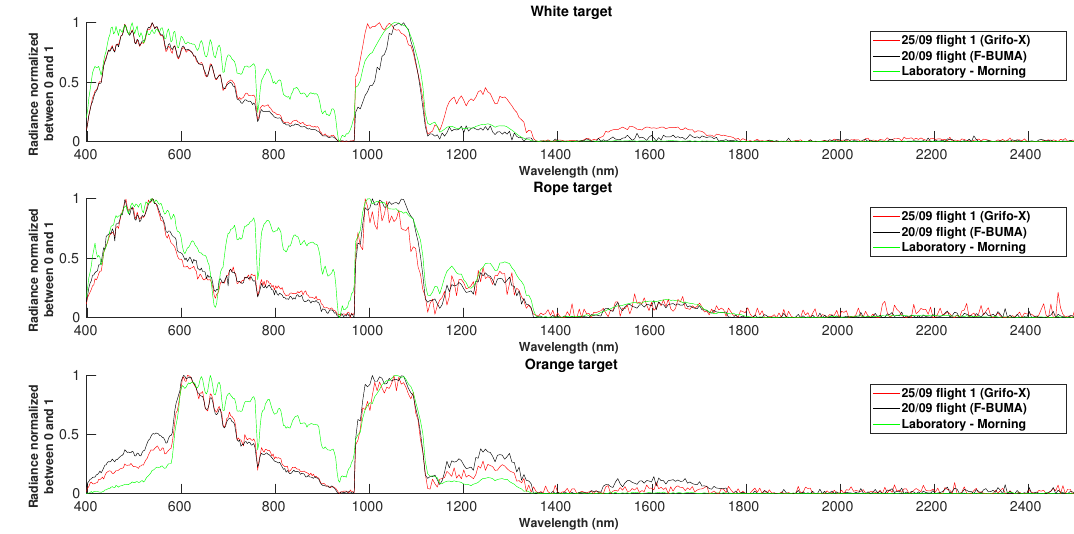
Figure A5 shows a comparison between the bright pixels for the 25/09 flight 1 with Grifo-X, 20/09 F-BUMA flight and the laboratory morning results for all the target materials.